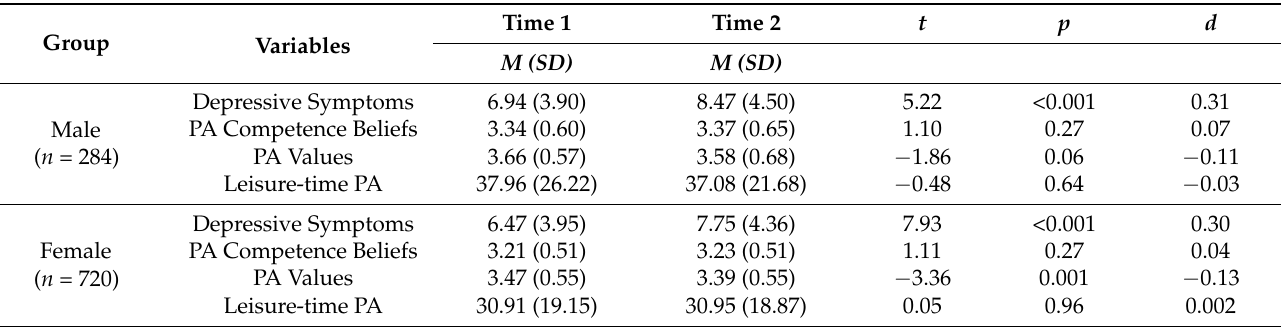
Table 2. The Results of the Paired t -test ( n =